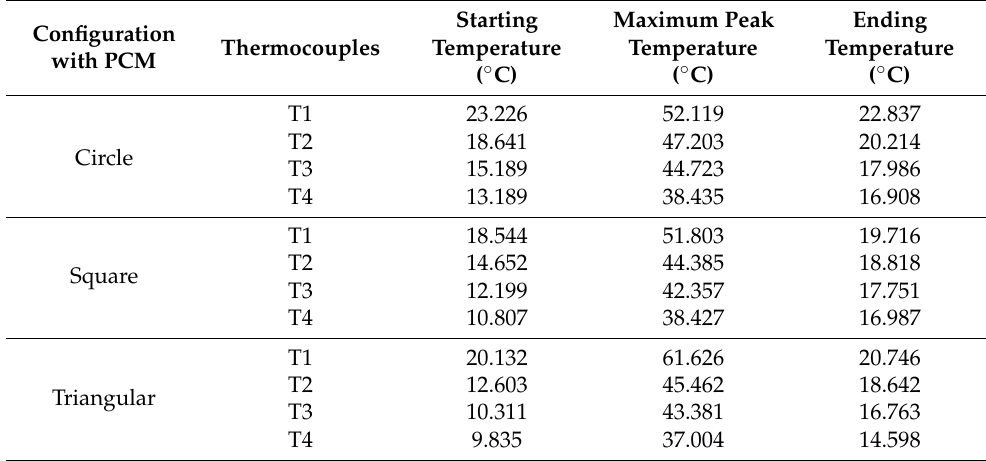
Table 4. Temperature data for configuration with